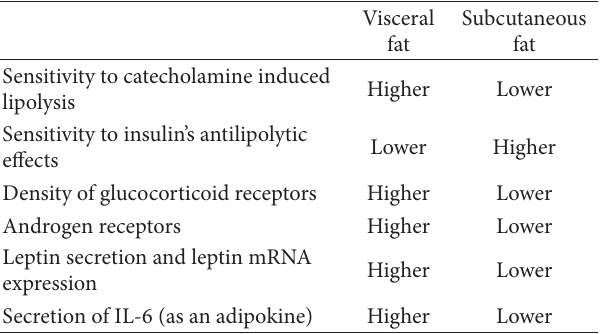
Table 3: Some differences between visceral and subcutaneous adipose tissue